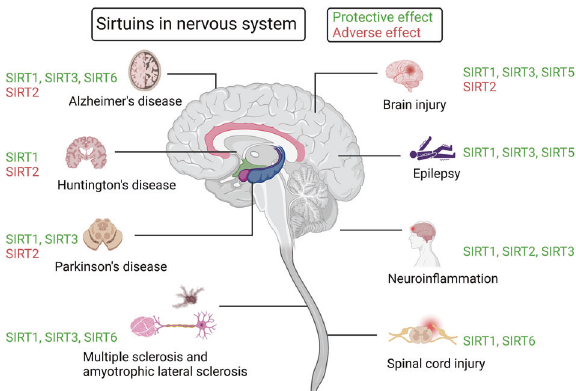
Fig. 13 The role of SIRTs in nervous system, mainly including AD, HD, PD, brain injury, epilepsy, neuroin fl ammation, SCI, multiple sclerosis and ALS. SIRT1, SIRT3, and SIRT6 have protective effects on AD, multiple scierosis and amyotrophic lateral scierosis. SIRT1 plays